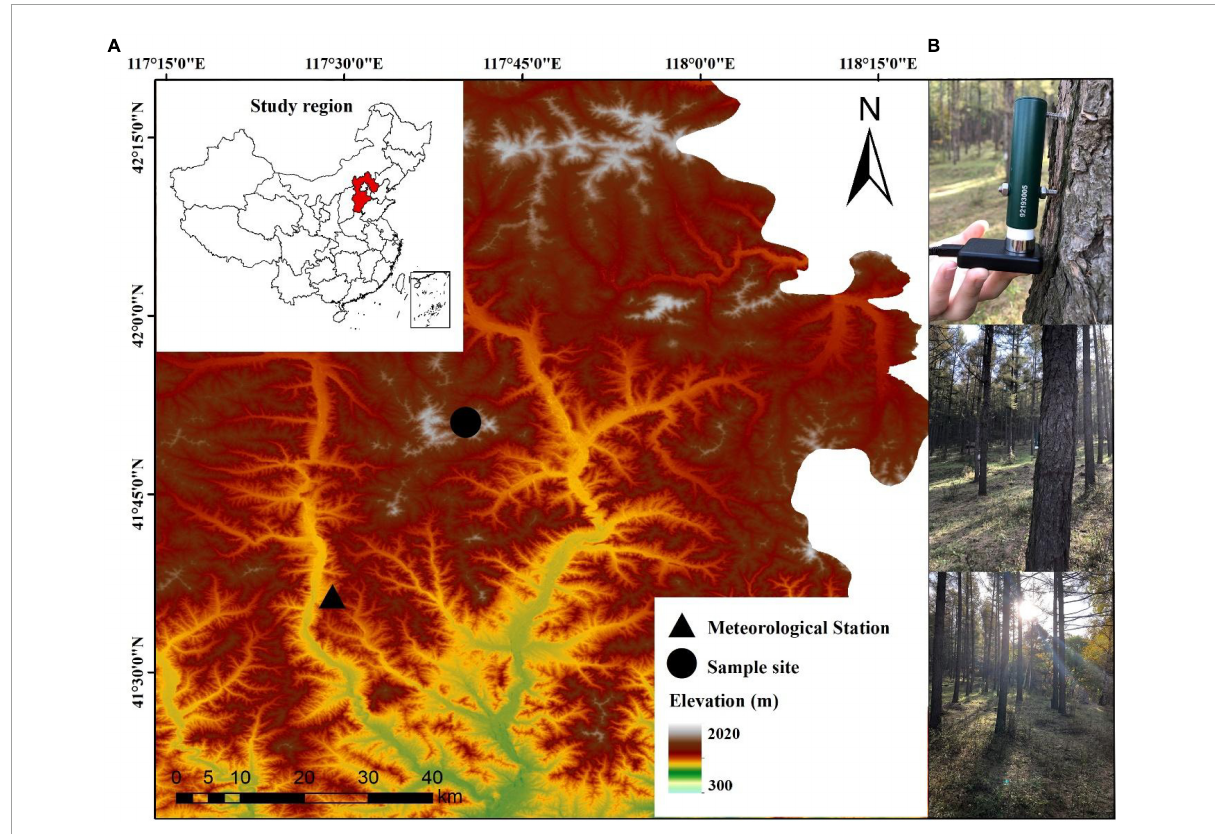
FIGURE1 (A) Location of the monitoring site (black circle) and the nearest meteorological station (black triangle). (B) Pictures show the forest structure and composition of our monitoring site, from top to bottom.